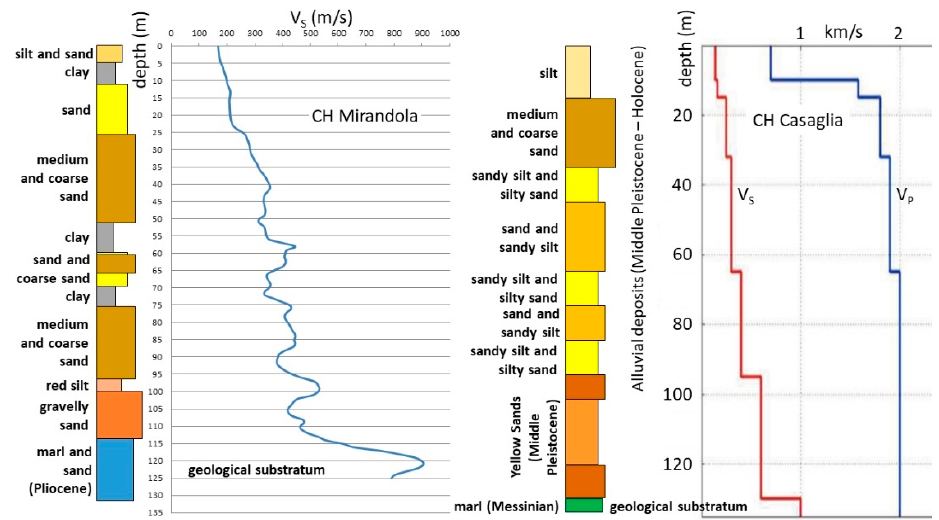
Figure 15. Stratigraphic logs and Vs profiles in Mirandola and Casaglia [19,22]. Results of ambient noise measurements carried out next to the boreholes (Figures 16 and 17) show, in both cases, a single peak of the H/V spectral ratio at a frequency of 0.9 Hz with high amplitude [19,22–24,34,35].